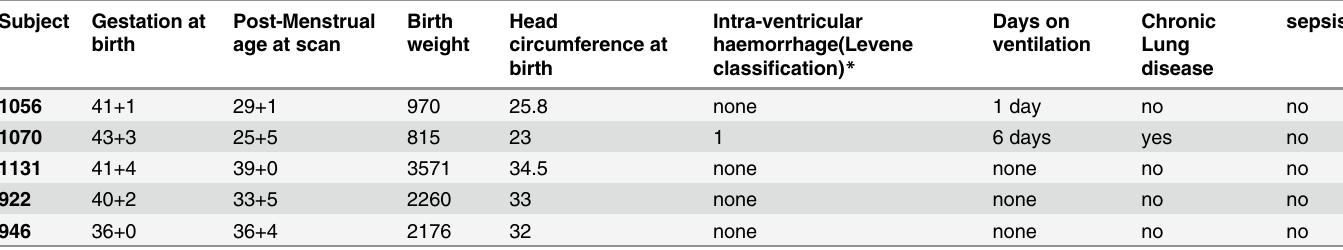
Table 1. Demographic and clinical details of the